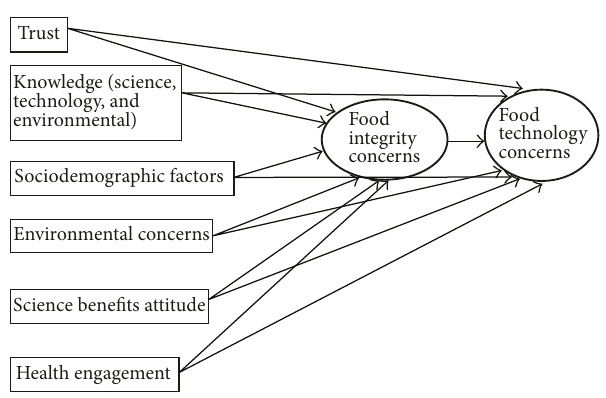
Figure 1: Hypothesized model of factors predicting influences of food integrity concerns and concerns for the food product of